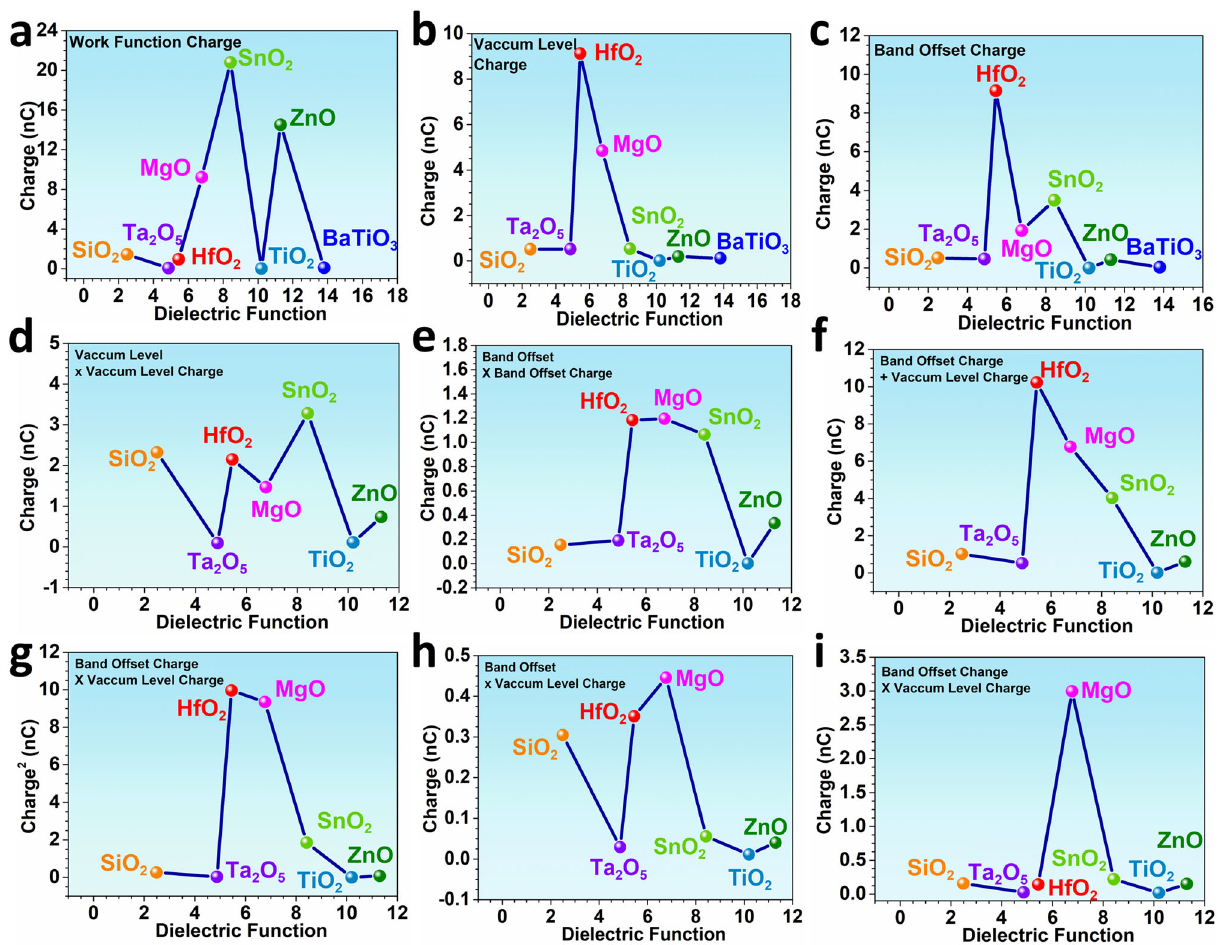
Fig. 6 The correlations between the dielectric functions and charge transfer which is calculated by different potential parameters. a The work function. b The vacuum level. c The band offset. d The vacuum level × the vacuum level. e The band offset × the band offset. f The band offset × the vacuum level. g The band offset calculated charge × the vacuum level calculated charge. h The band offset × the vacuum level calculated charge. i The band offset variation× the vacuum level